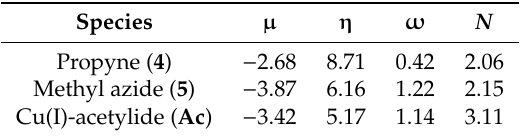
Table 5. Global reactivity indices (in eV) of the reagents involved in CuAAC reactions catalyzed by Cu(I)-abt.